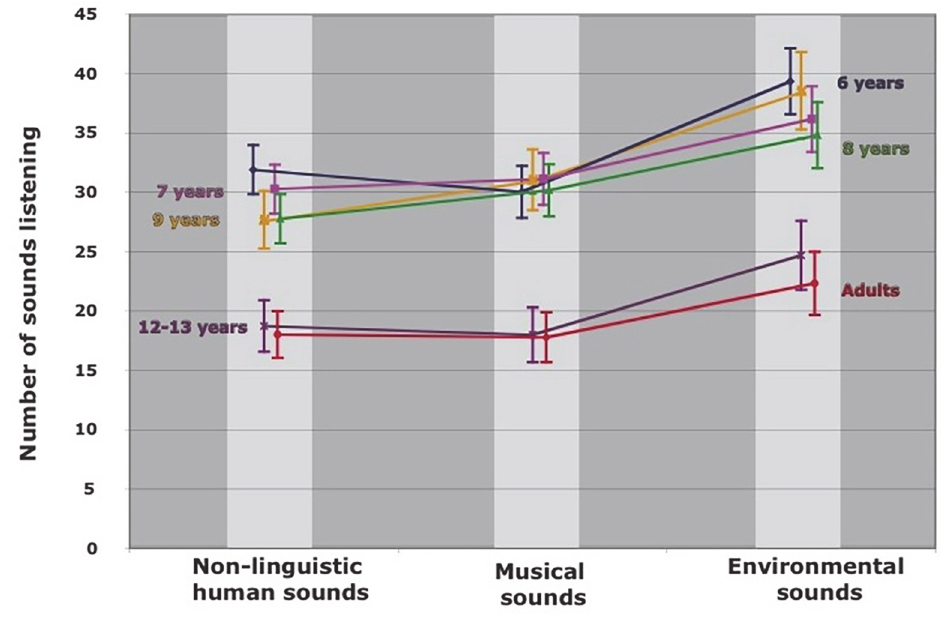
Fig 2. Average number of sounds listening as a function of age and of the a priori category. There are a significant differences between age groups and categories.